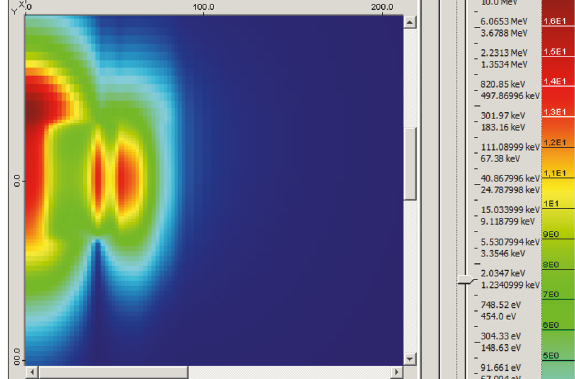
Figure 11: Distribution of the 1-2keV neutron flux in MYRRHA calculated using the PARTISN code.